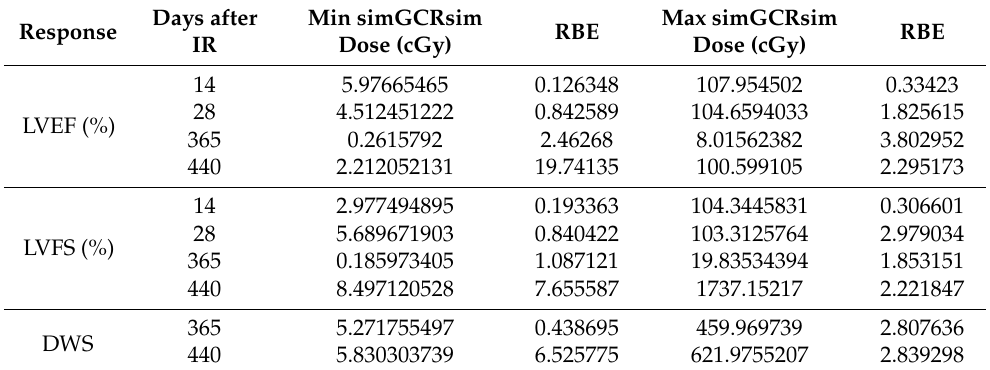
Table 1. RBE values at the minimum and maximum simGCRsim dose range where the calculation was defined. The models for LVFS on day 440 and for DWS were more linear in shape, and therefore showed an RBE and maximum simGCRsim dose near the theoretical maximum response level of 100%.